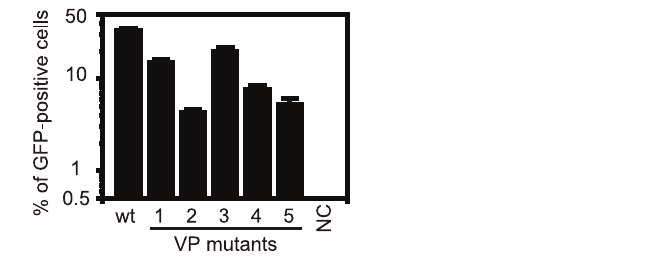
Figure 5. HEK293 cell transduction with wild type AAV2 and viable AAV2 VP heptapeptide mutants. HEK293 cells were infected with dsAAV2-CMV-GFP encapsidated with wild type or mutant capsid at MOI of 20,000. The mutant capsids carried the following VP heptapeptide mutants: 1, SAYWVTQ; 2, TVWASSV; 3, CLHDVMS; 4, SVHDACV; and 5, GVFWVGV. Forty-eight hours post-infection, percent- age of GFP-positive cells was determined by flow cytometry. Non- transduced cells were used as a negative control (NC). Vertical bars represent standard deviations.